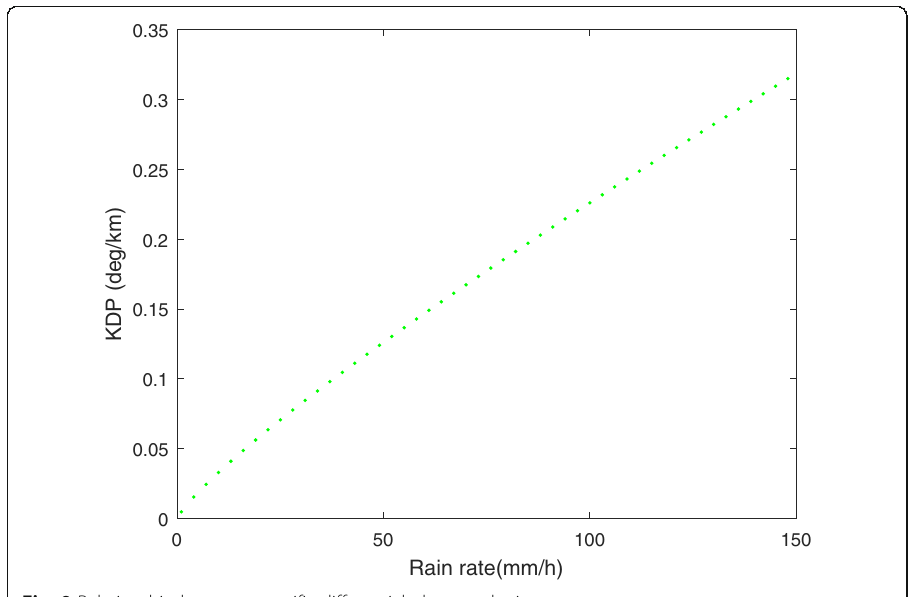
Fig. 9 Relationship between specific differential phase and rain rate